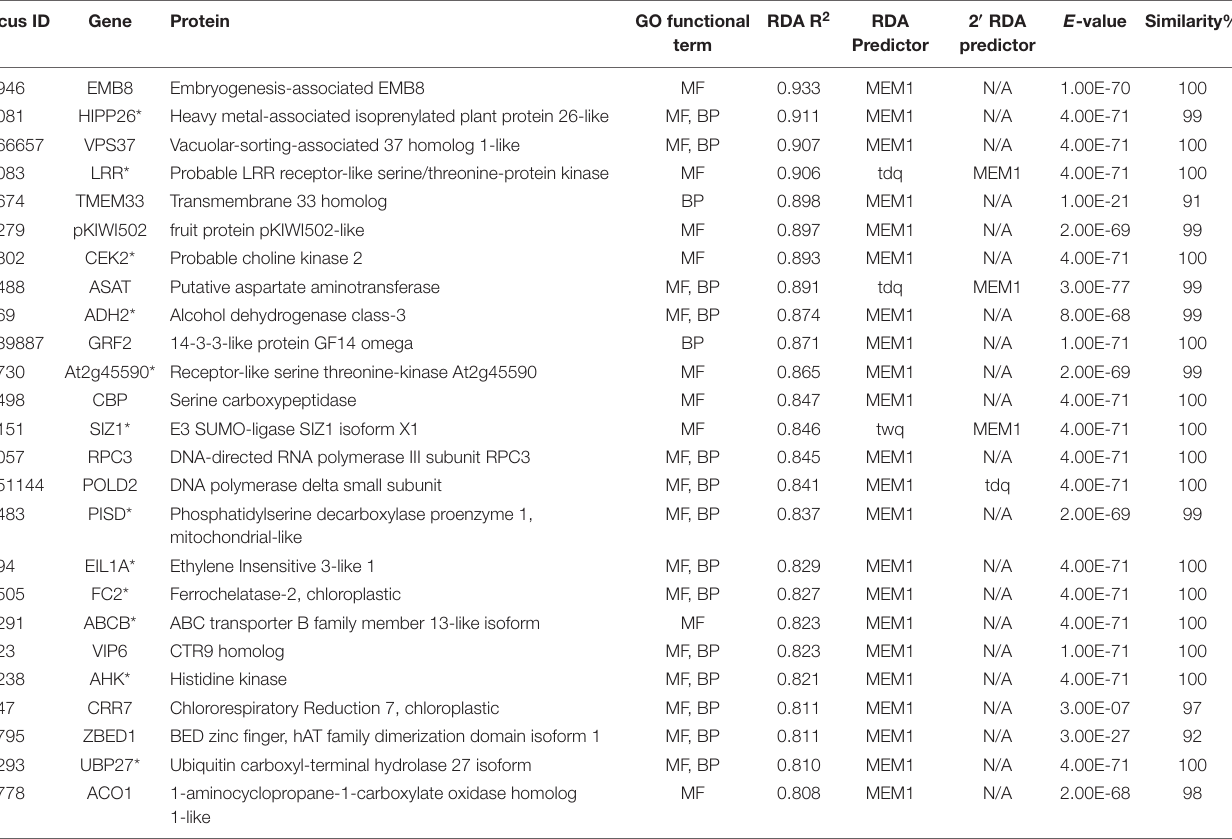
TABLE 4 | Annotated Eriophorum vaginatum candidate genes with a percentage identity match of at least 80.0 and an E -value threshold of at least 1 × 10 − 4 and RDA R 2 value ≥ 0.8. Locus ID Gene Protein GO functional